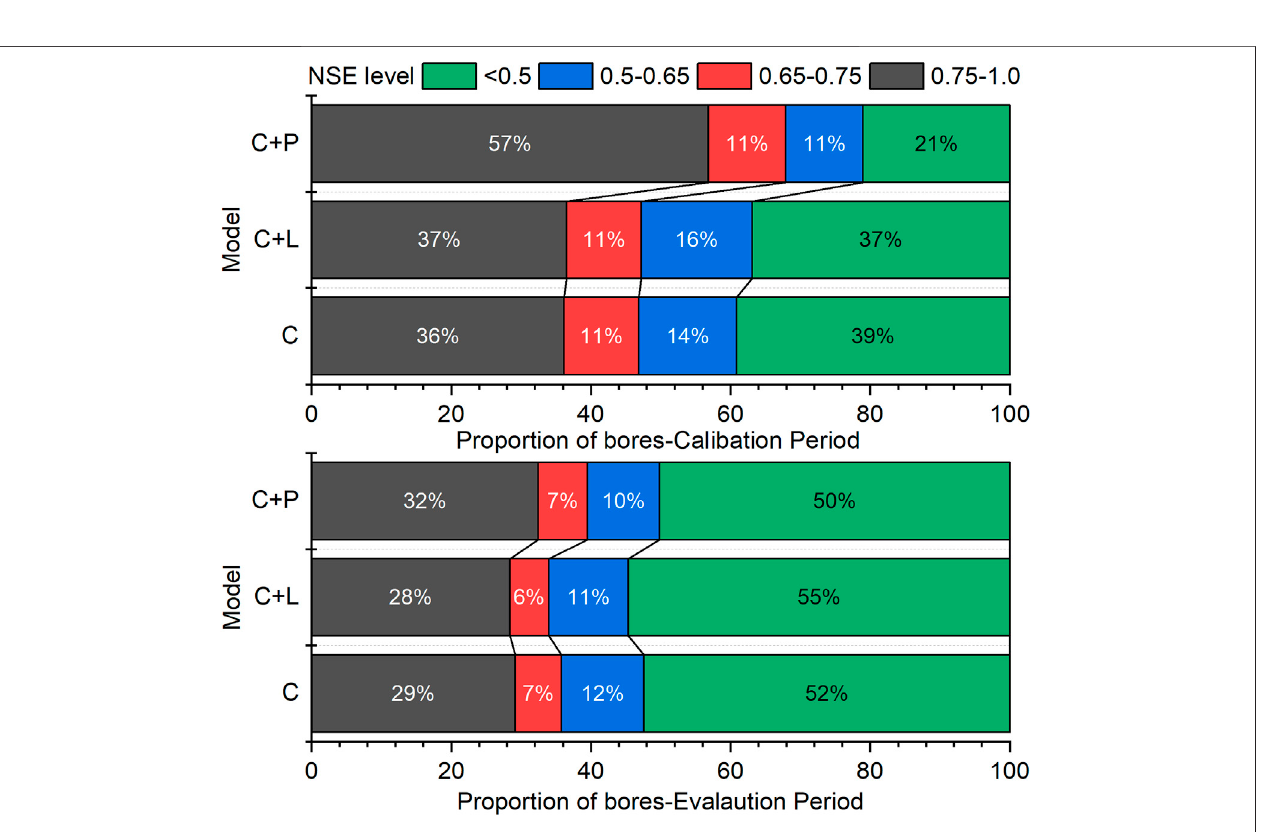
Frontiers in Environmental Science |